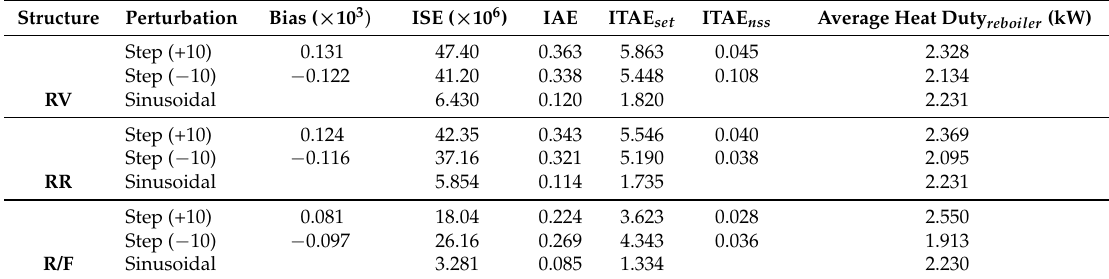
Table 7. Performance indicators of control structures—case of feed composition perturbations.